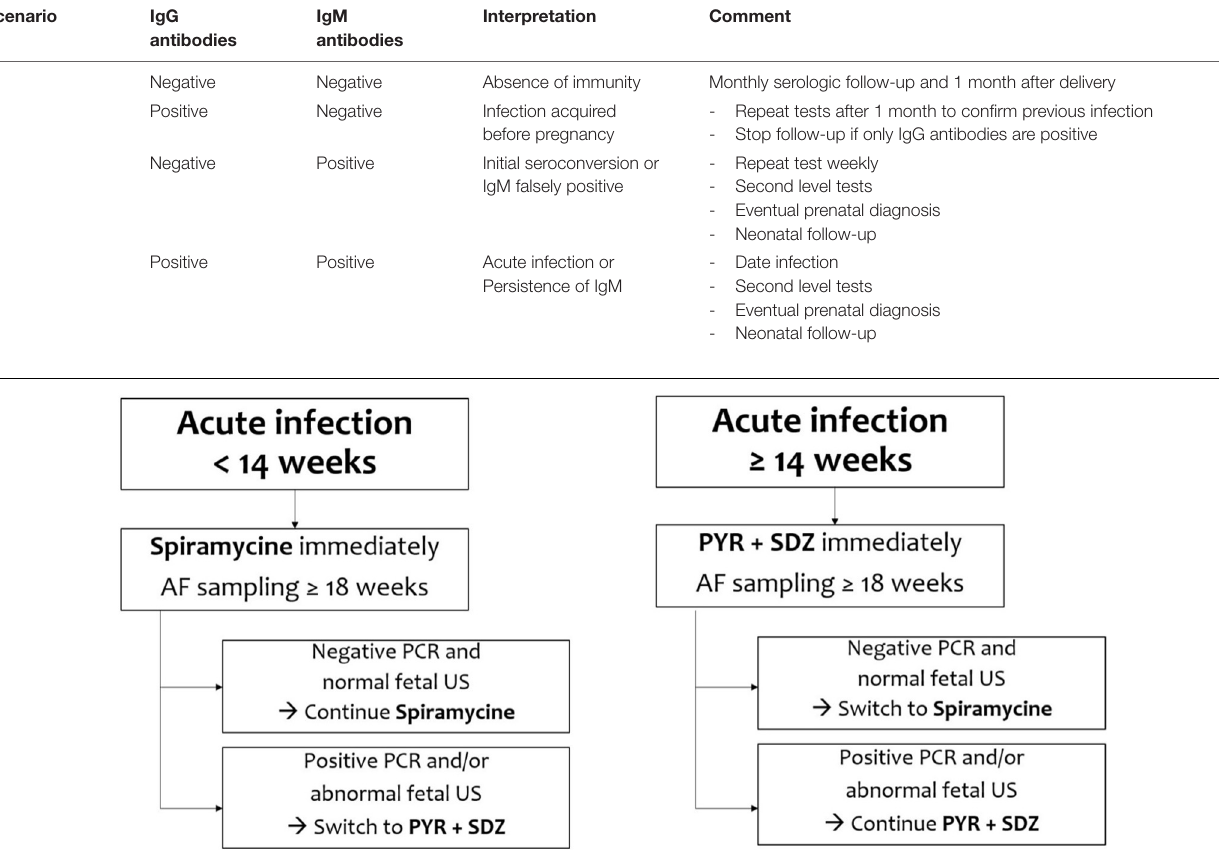
FIGURE 2 | Pharmacological prevention of mother-to-child transmission.